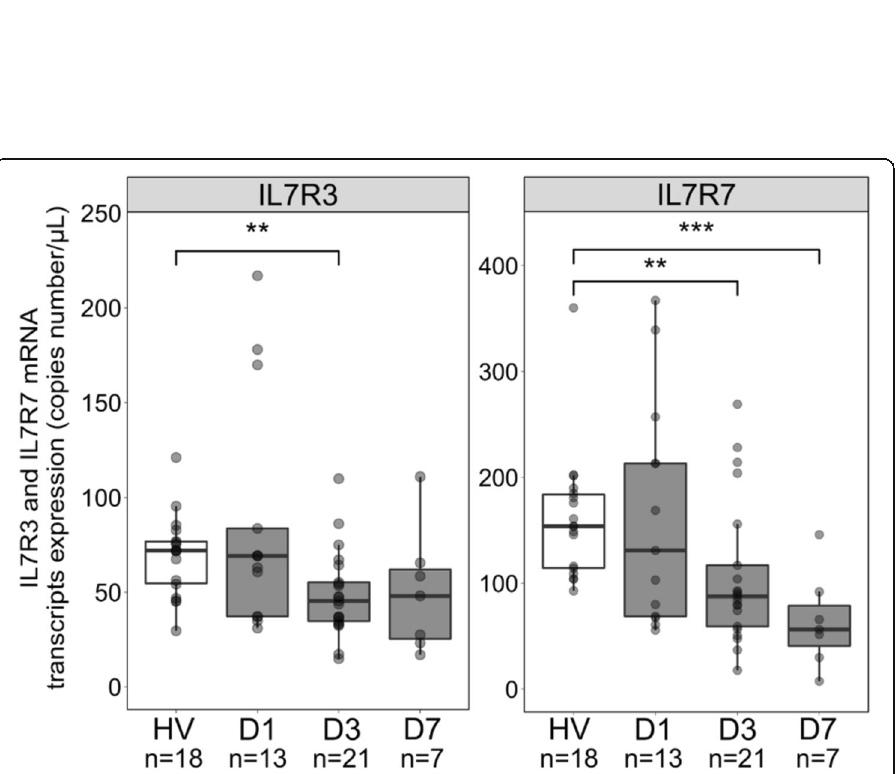
Fig. 2 IL7R mRNA transcripts expression in purified T cells from septic shock patients. Gene expressions of the IL7R3 and IL7R7 transcripts were measured using RT-qPCR from RNA from purified T cells from septic shock patients at D1 ( n = 13), D3 ( n = 21), and D7 ( n = 7) in comparison with HV ( n = 18). Data are presented as Tukey boxplots. Mann-Whitney tests were used to compare values between septic shock patients and HV. ** p < 0.01, *** p < 0.001. See Additional file 1 for